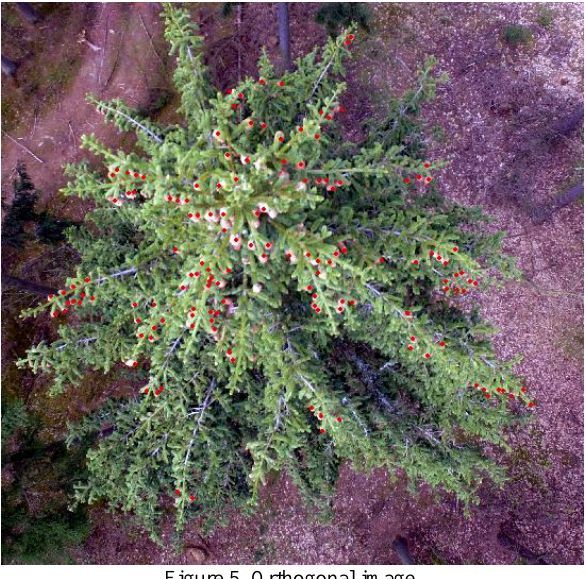
Figure 5. Orthogonal